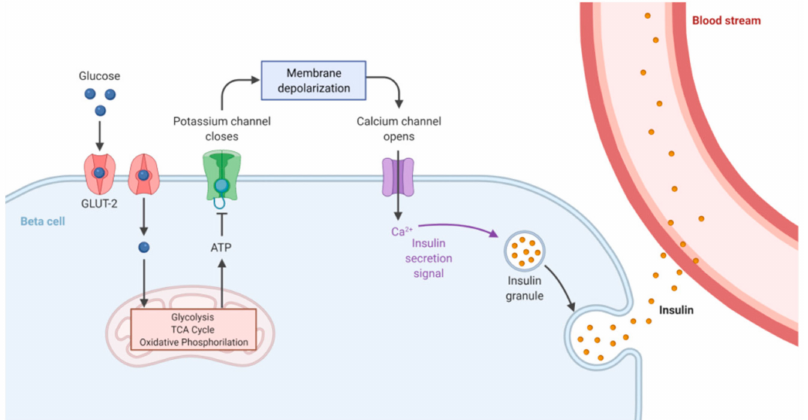
Figure 1. Insulin secretion mechanism. Glucose is transported into pancreatic beta cells through facilitated diffusion by GLUT2 glucose transporters. Intracellular glucose is metabolized to ATP through glycolysis and oxidative phosphorylation. A high ATP/ADP ratio induces closure of K + channels, leading to cell membrane depolarization. This event promotes the opening of Ca 2+ channels, facilitates extracellular Ca 2+ influx into the beta cell, and in turn triggers insulin exocytosis. Adapted from “Insulin Production Pathway”, by BioRender.com (2021). Retrieved from https: //app.biorender.com/biorender-templates, accessed on 15 September